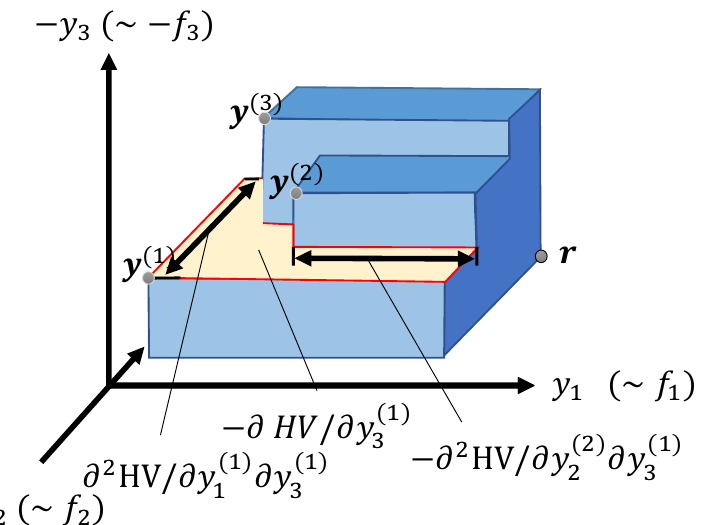
Figure 1. Example of a hypervolume indicator Hessian computation in three-dimensional objective space with a collection of points